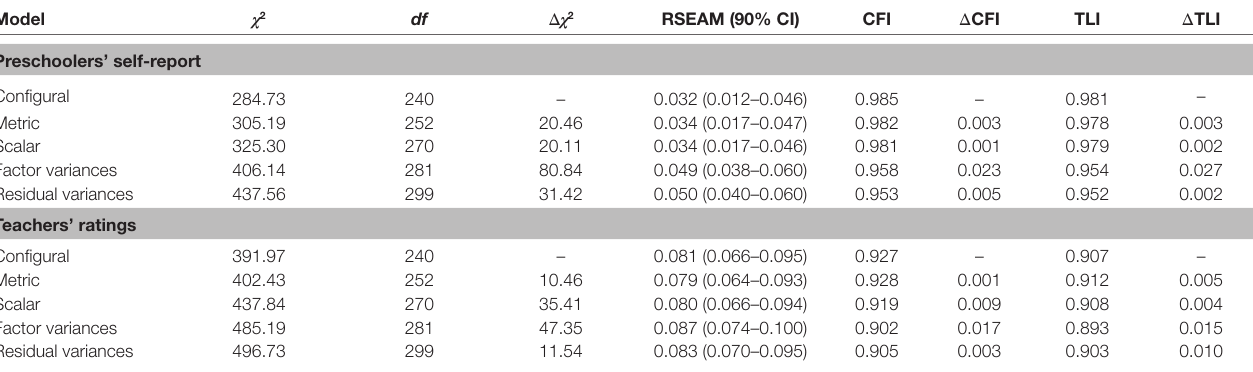
TABLE 2 | Measurement invariance tests of the 6-factor